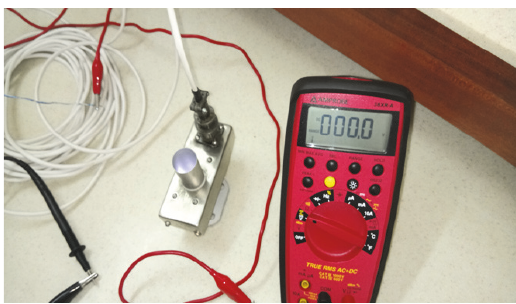
Figure 19: Illumination of led in sample slot phototransistor outputs 0.00 volts.